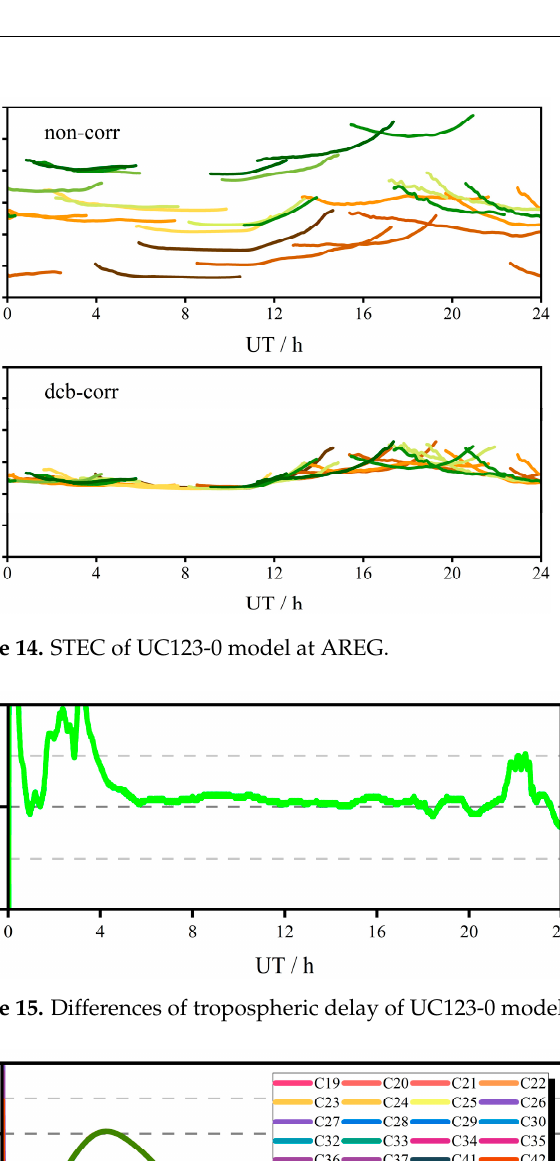
Figure 15. Differences of tropospheric delay of UC123-0 model at AREG.